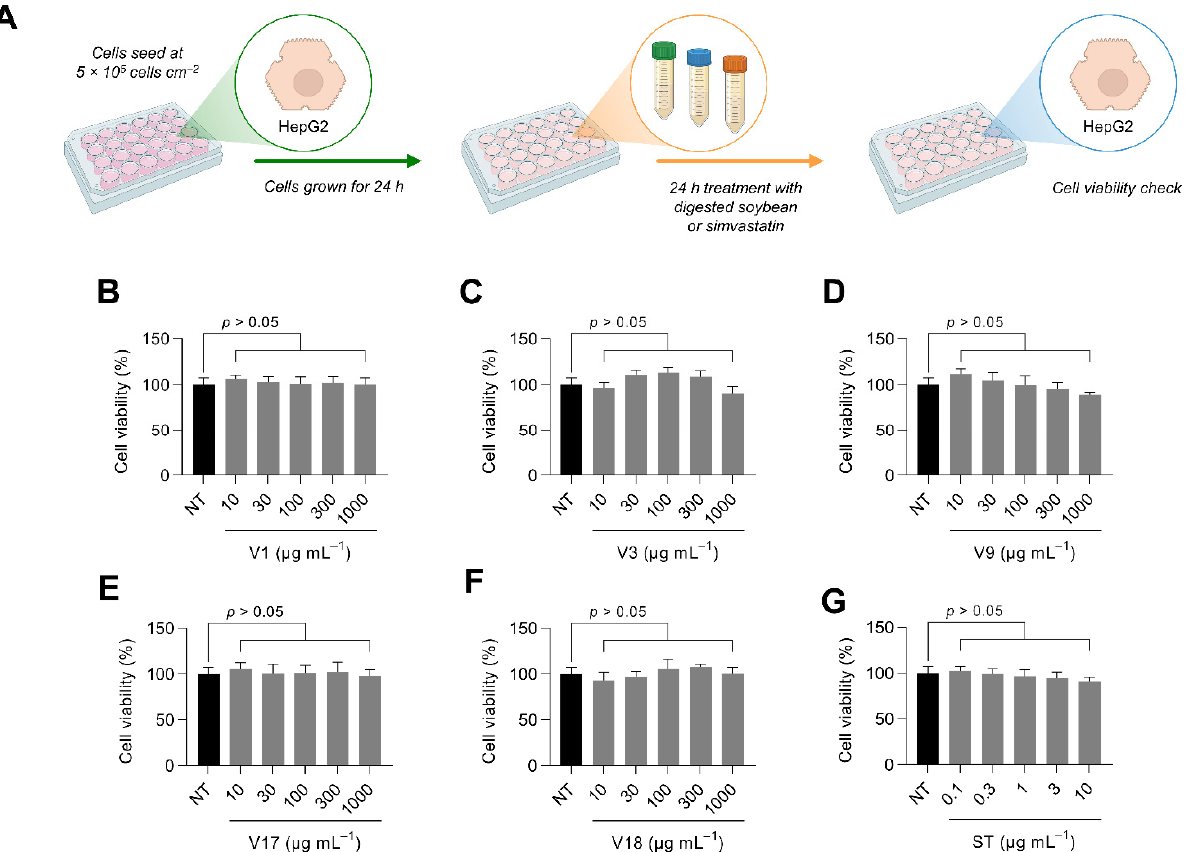
Figure A2. Illustrative diagram of the experimental design followed for evaluating cell viability under basal conditions ( A ). Basal cell viability of selected digested soybean varieties ( B – F ) and simvastatin ( G ). Results are reported as mean ± SD ( n = 3).